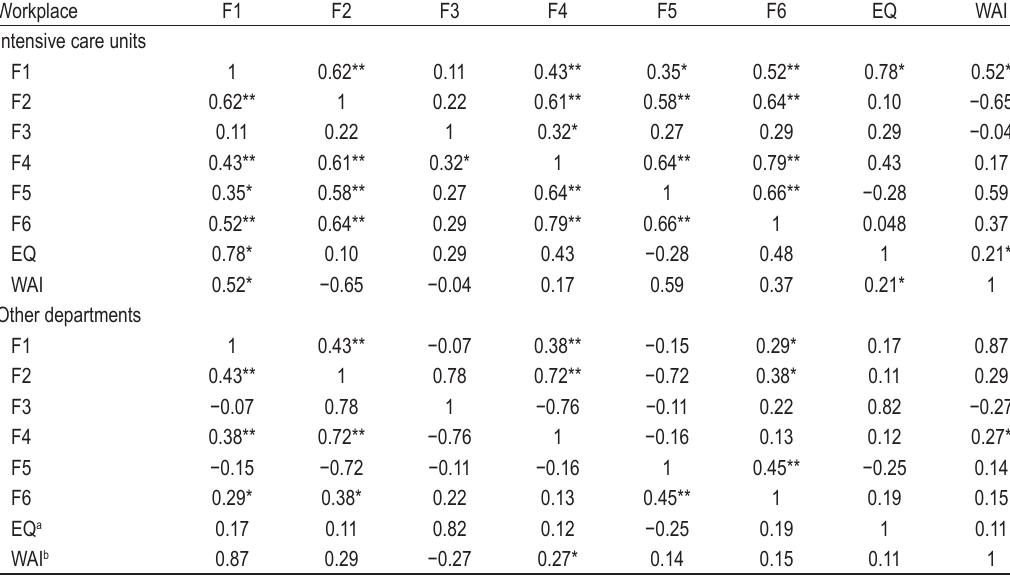
TABLE 3. Correlation matrix of stress factors, empathy, and workability by workplace